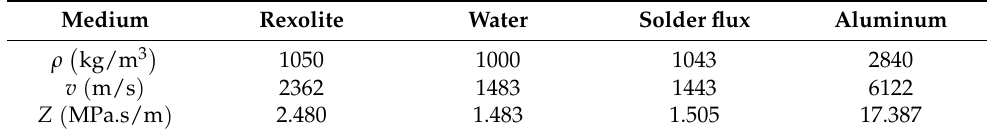
Table 5. Physical and acoustic properties of the media used in the experimental ultrasonic tests at room temperature.